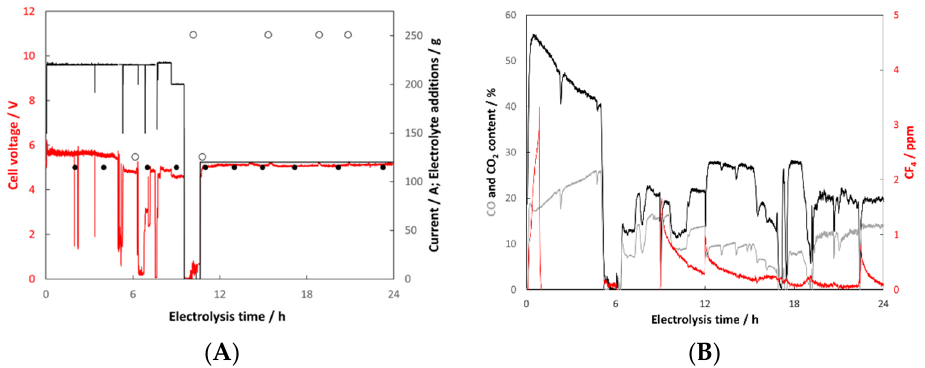
Figure 4. ( A ) Cell voltage recorded during the electrolysis trial. Galvanostatic operation at 220 A during the first 9 h, and then 120 A. Al 2 O 3 was continuously fed through an automatic feeder. ( ) Sc 2 O 3 and ( ) electrolyte additions are also shown in the graph; ( B ) On-line analysis of the cell off- gases.